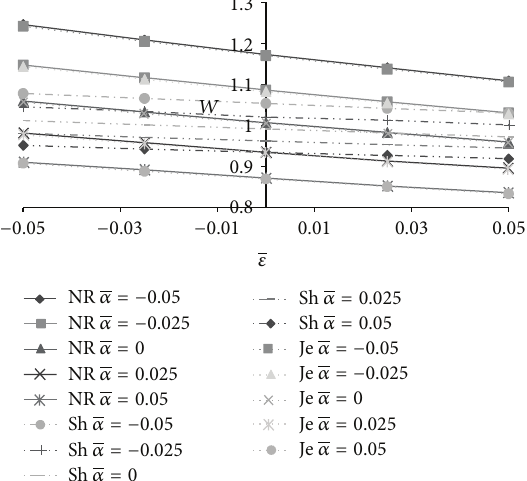
Figure 11: Variation of load carrying capacity with respect to 𝜀 and 𝛼 .